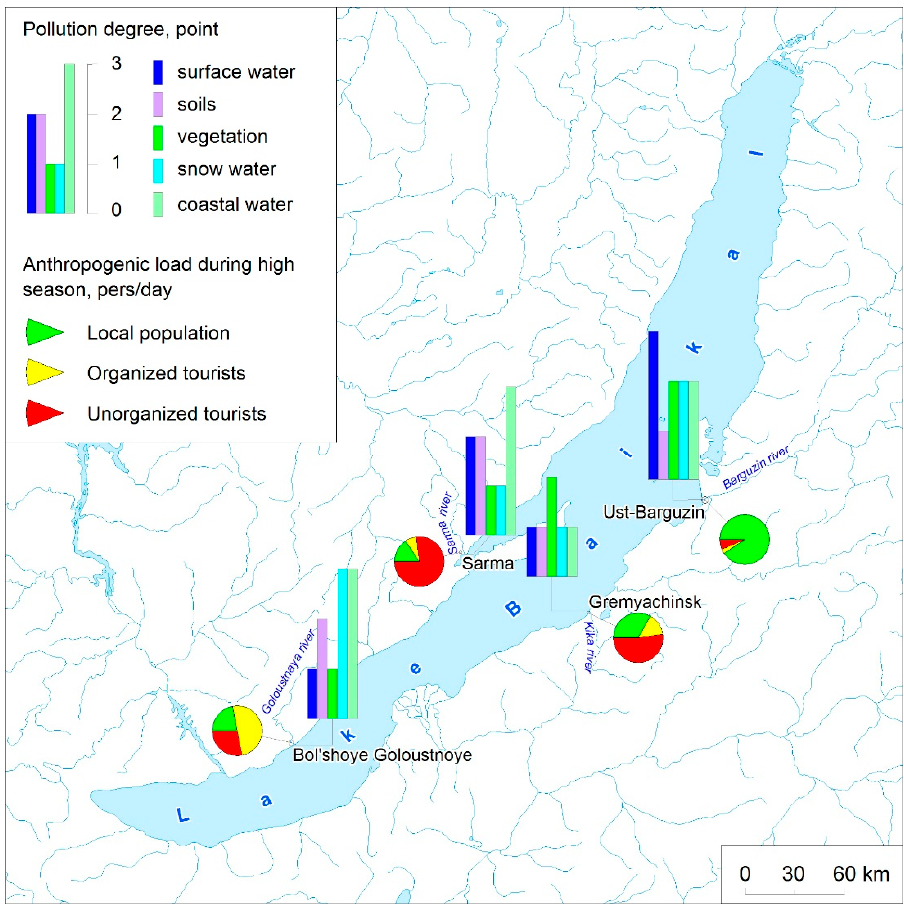
Figure 1. Ecological state of the mouth areas of model tributaries of Lake Baikal.